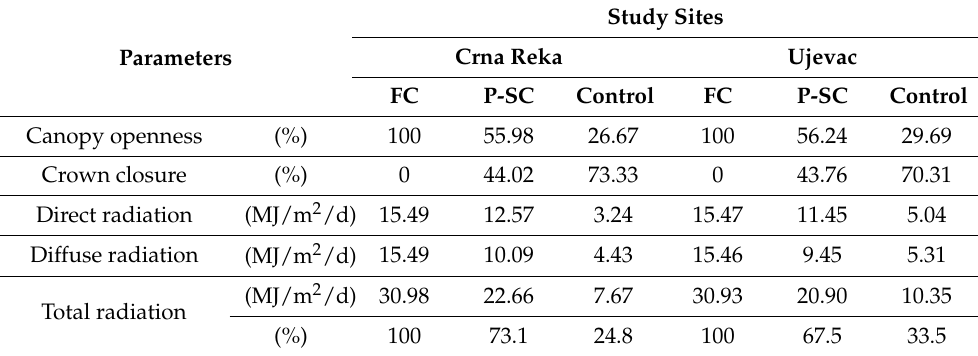
Table 1. Canopy openness and light availability in the experimental units. FC, final cut; P-SC, preparatory-seed